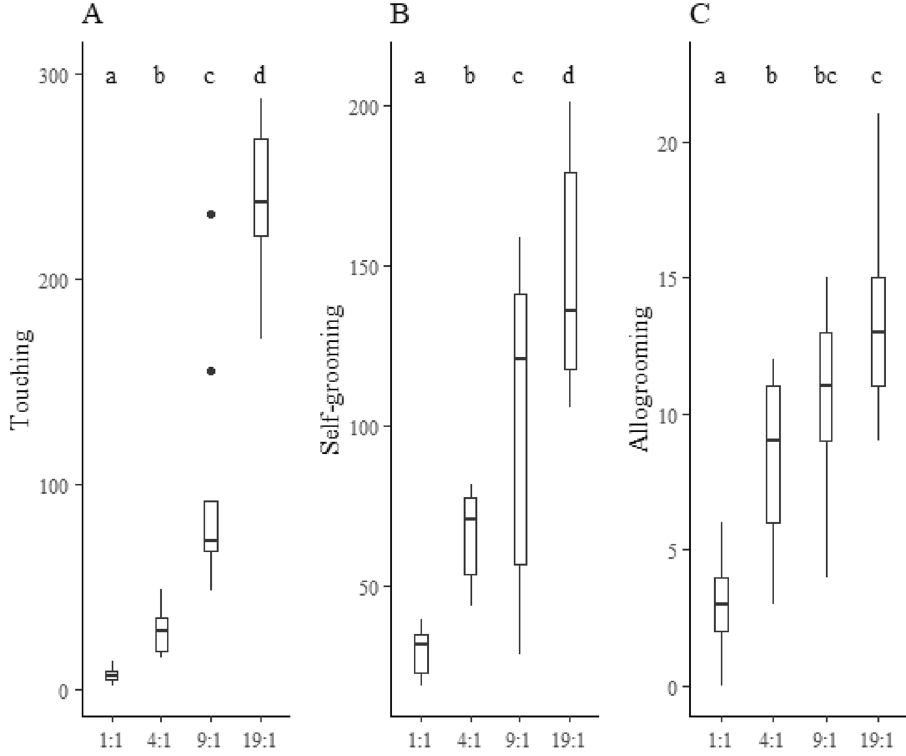
Figure 2. Frequency of behavioral acts of Atta sexdens rubropilosa (Hymenoptera: Formicidae) workers in the control (T1), quinone inside inhibitors fungicide 0.1% (T2) and quinone inside inhibitors fungicide 1.0% (T3) treatments. Values followed by the same letter per behavior do not